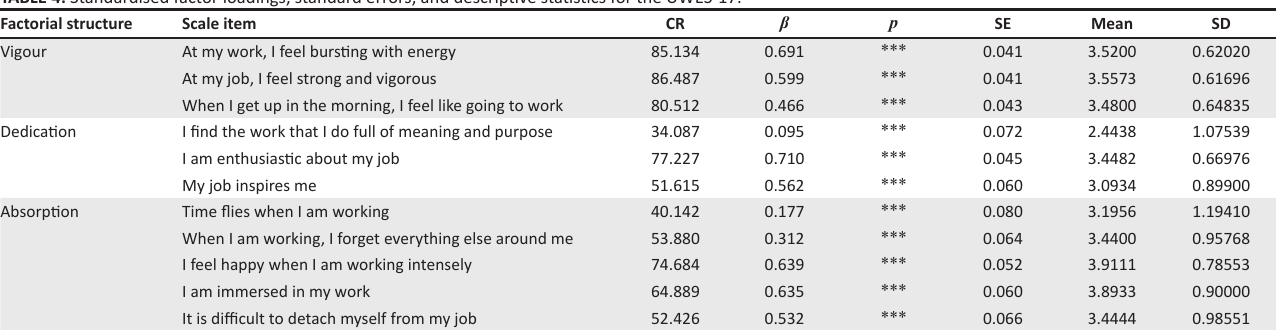
TABLE 4: Standardised factor loadings, standard errors, and descriptive statistics for the UWES-17. Factorial structure